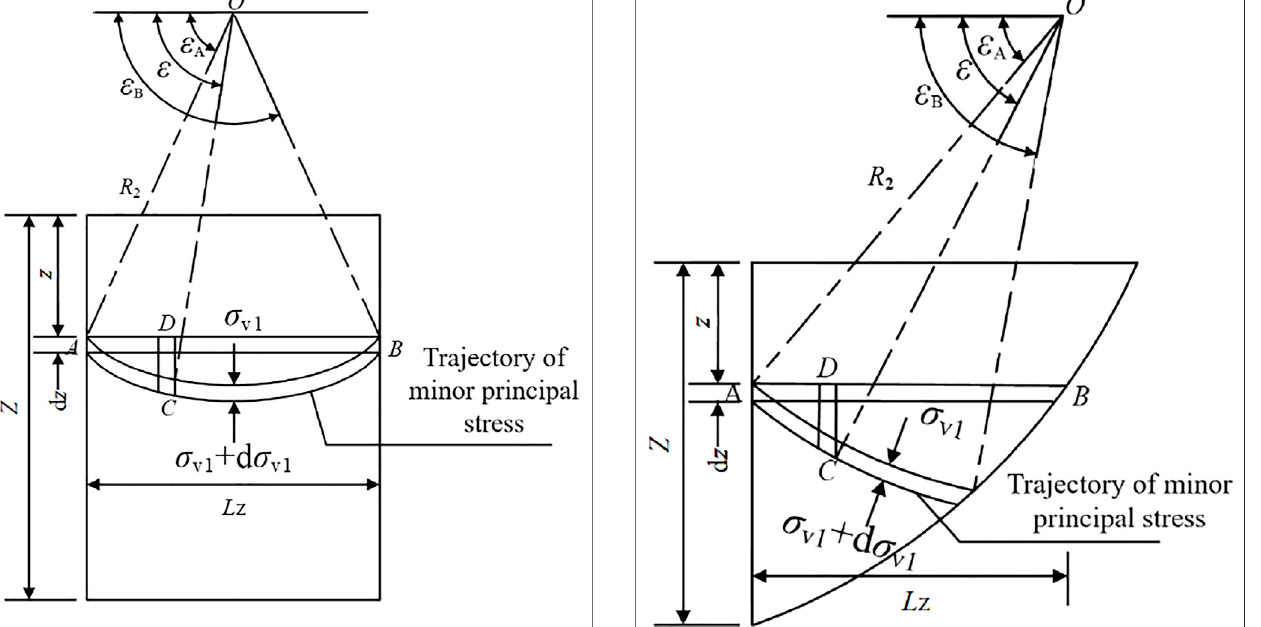
FIGURE 3 | Trajectory of minor principal stress of Zone I